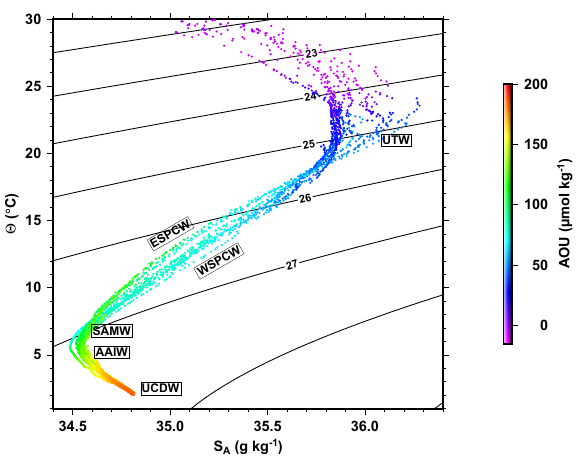
Figure 2. (cid:50) − S A diagram with colors indicating the AOU. Black contour lines represent the isopycnal horizons based on potential density referenced to a pressure of 0dbar ( σ θ